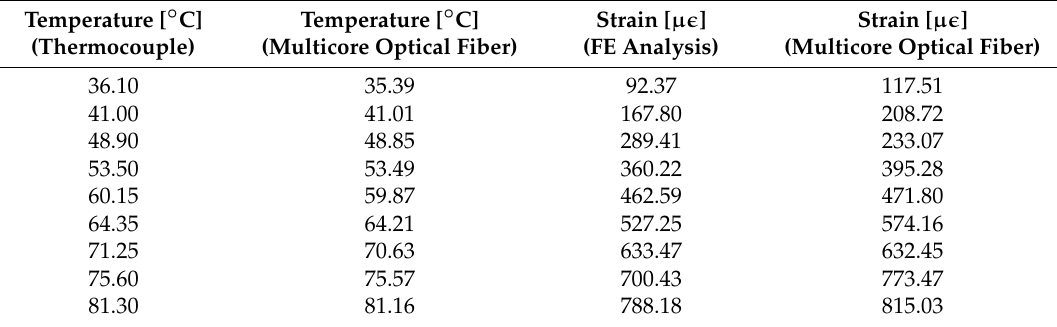
Figure 4. Measurements obtained from dual-core samples for ( a ) temperatures plotted against thermocouple-measured temperatures, and ( b ) strains versus finite-element computed strains. The deviation of these slopes from unity indicates the system error. Table 2. (First column) Temperature of metal cylinder as measured by thermocouple; (second column) temperature of metal cylinder as measured using the multicore optical fibers; (third column) strain exerted by metal cylinder as determined by FE analysis; and (fourth column) strain exerted by metal cylinder as measured using the multicore optical fibers as described in the